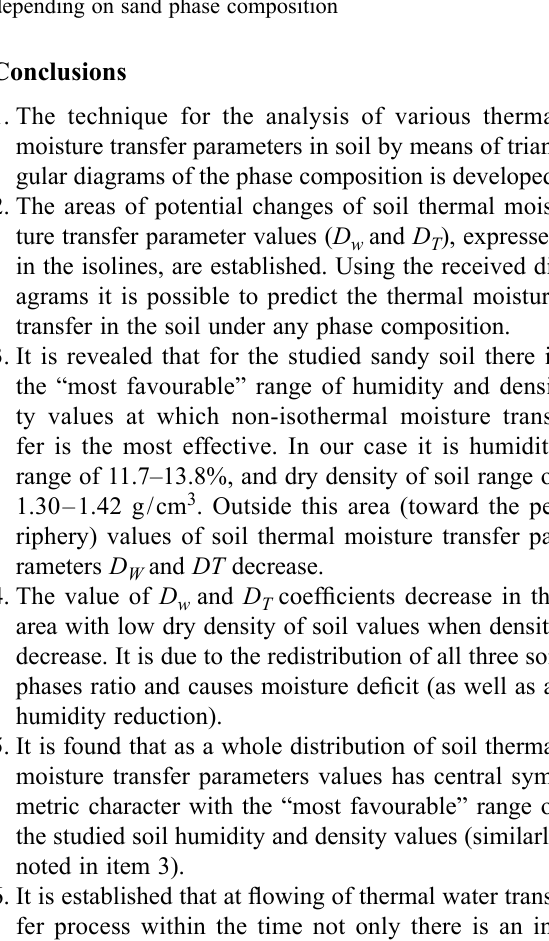
9. Diagram of redistributed moisture share values Σ WT (%): a – through 4 h; b – through 20 h after the experience beginning depending on sand phase